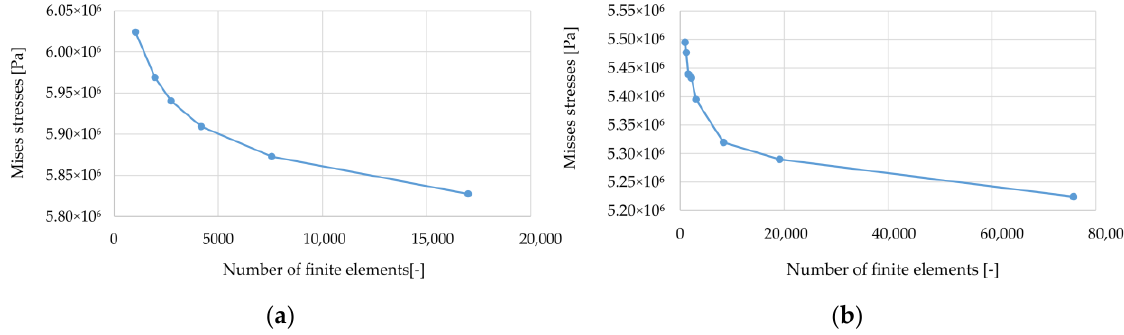
Figure 6. Mises stresses at point C (see Figure 2) depending on the number of elements: ( a ) variant B1; ( b ) variant B2.